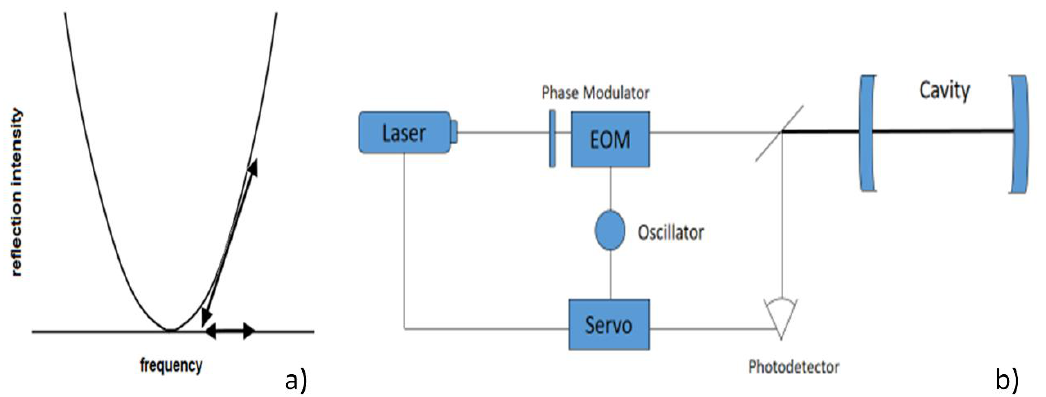
Figure 19. ( a ) Cavity reflection intensity vs. frequency; ( b ) example of an experimental set-up for PDH techniques.